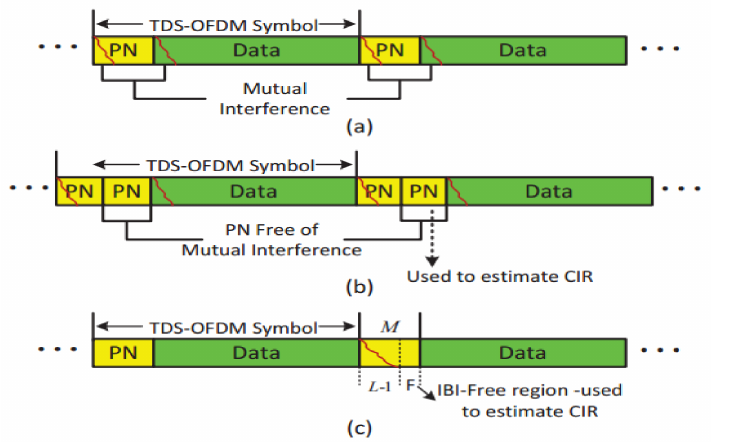
Figure 4. Received signal frame structure. ( a ) Conventional TDS ‐ OFDM, ( b ) DPN ‐ TDS ‐ OFDM, ( c ) CS based TDS ‐ OFDM.